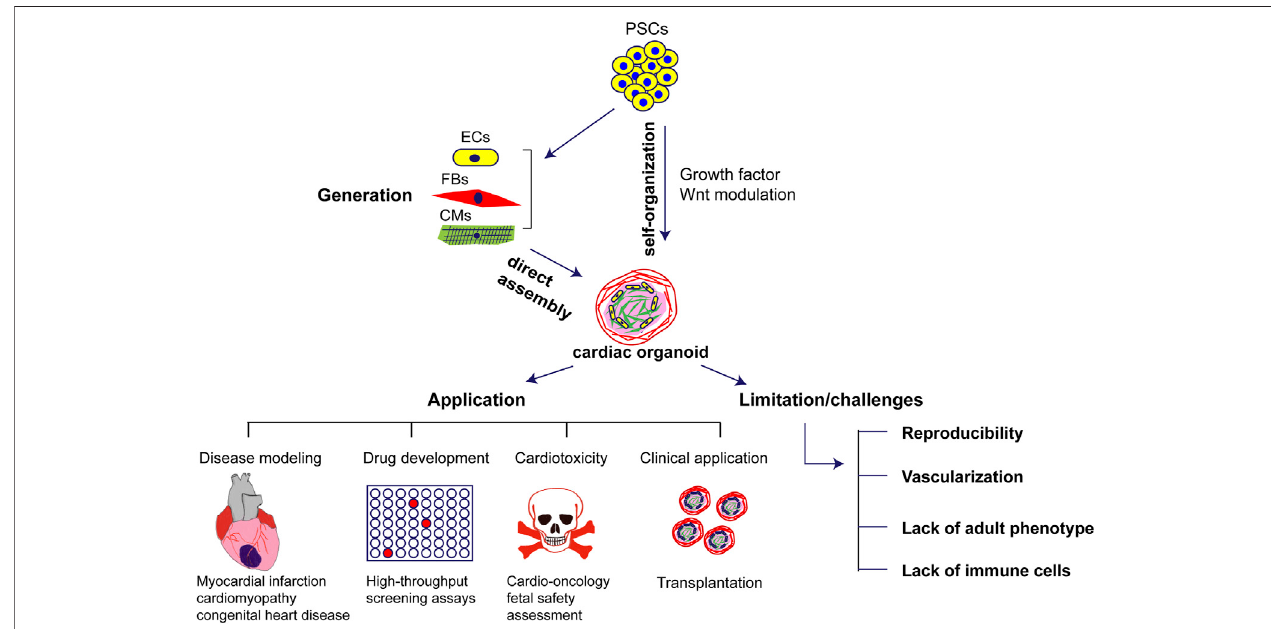
FIGURE 1 | Generation, application and challenges of human cardiac organoids in cardiovascular diseases. PSCs: pluripotent stem cells; ECs: endothelial cells; FBs: fi broblasts; CMs: cardiomyocytes.